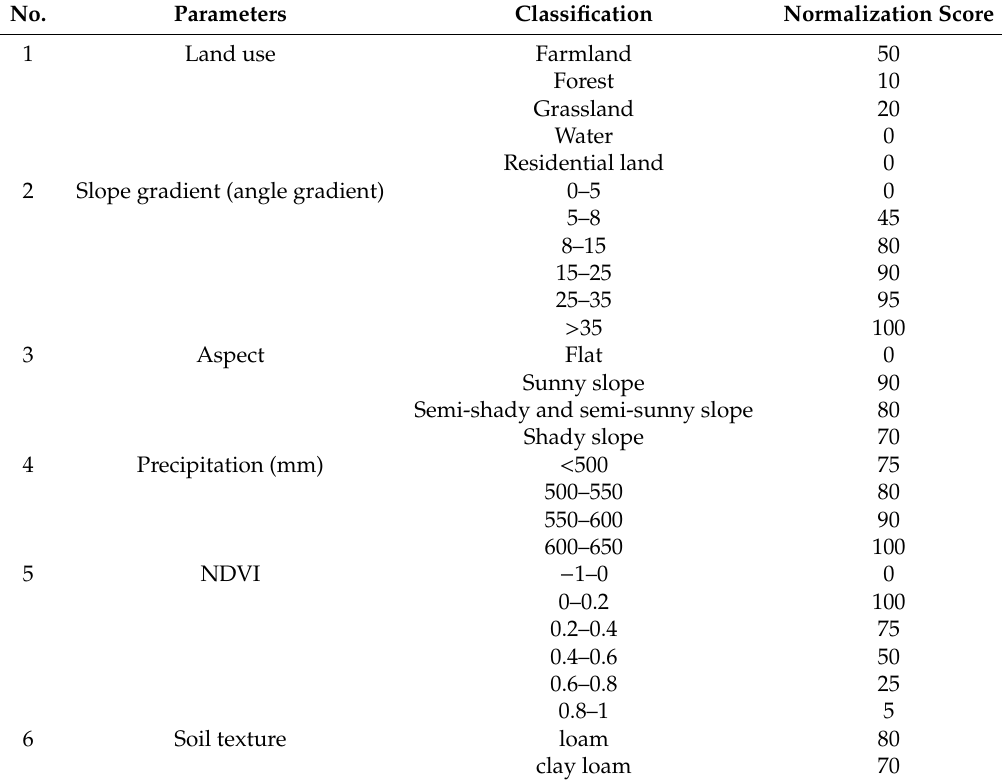
Table 2. Classification and normalization score of soil erosion risk